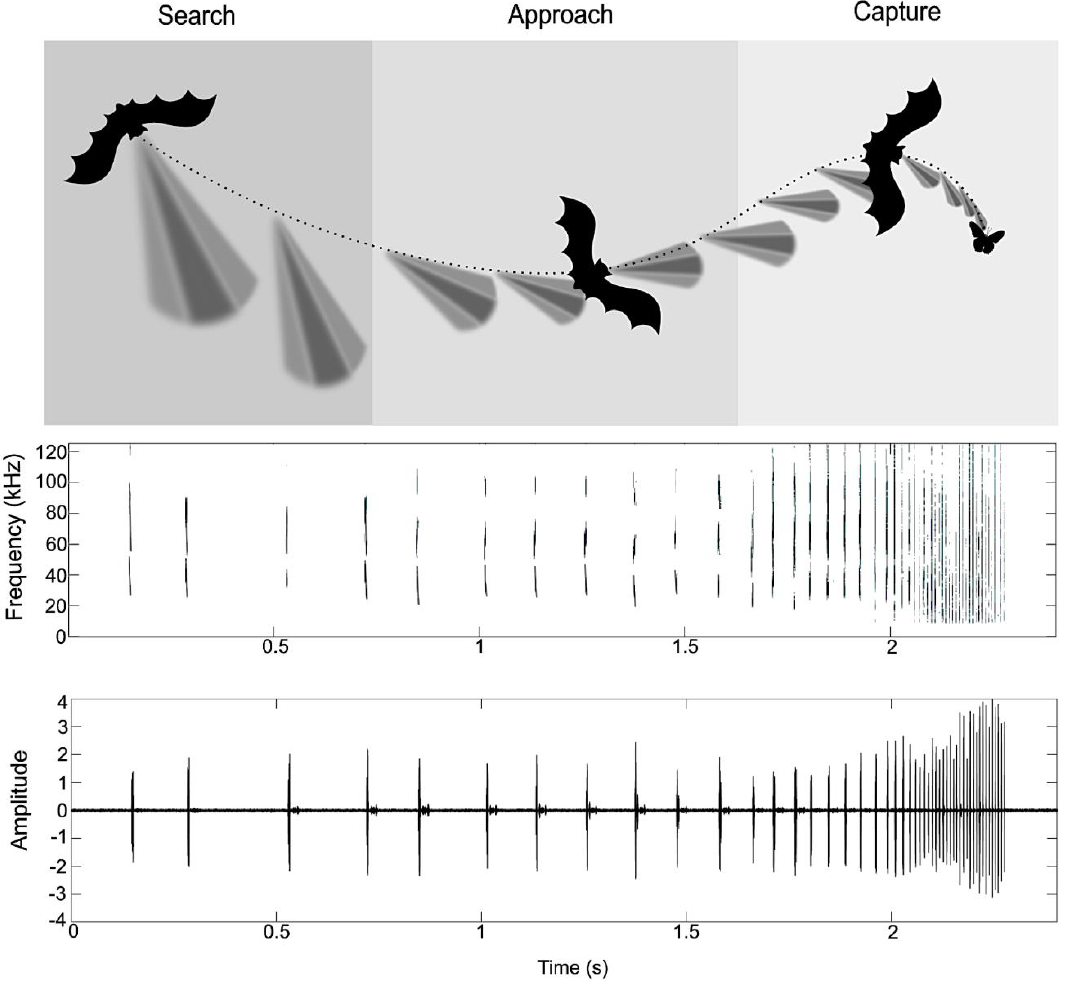
Figure 2. Classic insect-pursuit sequence of an FM bat. The top panel shows a depiction of a bat pursuing an insect. The grayscale fans illustrate the directional aim of the bat’s sonar beam, with the darkest regions illustrating the beam axis containing greatest sound energy. In the search phase, bats orient their beam aim to scan the environment in di ff erent directions and emit narrowband, long-duration sonar calls. The approach phase commences when echo information about a target returns to the bat; it is characterized by an increase in FM bandwidth, the bat locking its sonar beam aim onto the selected target, and the bat increasing its rate of sonar calls. Finally, when the bat moves to capture the insect, it emits a quick succession of calls, further decreasing the inter-pulse interval, until it intercepts the target. The center panel depicts spectrograms (time frequency representations) of natural echolocation calls from a target tracking sequence of a big brown bat, Eptesicus fuscus , in the lab, and shows the approach and capture phases of insect pursuit (low signal-to-noise ratio may have a ff ected the quality of the spectrograms of some signals). The lower panel shows the waveform of the above sequence. Increases in signal amplitude with decreasing target distance are an artifact of the recording conditions. These panels illustrate the change in sonar-call repetition rate in a bat approaching and intercepting a target.